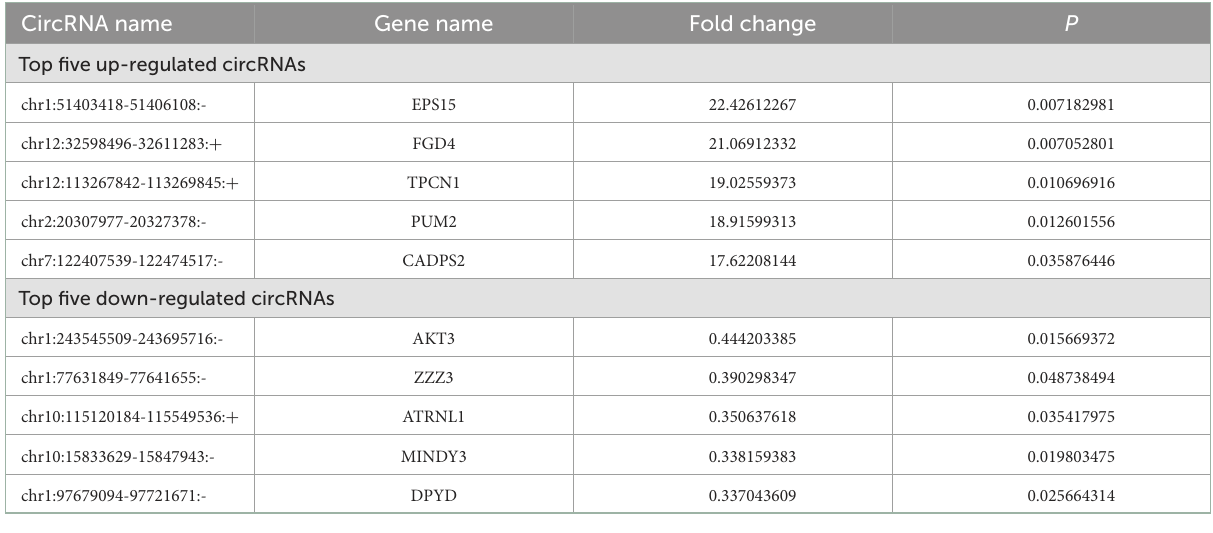
TABLE 3 Top five up- or down-regulated circRNAs after TBI.